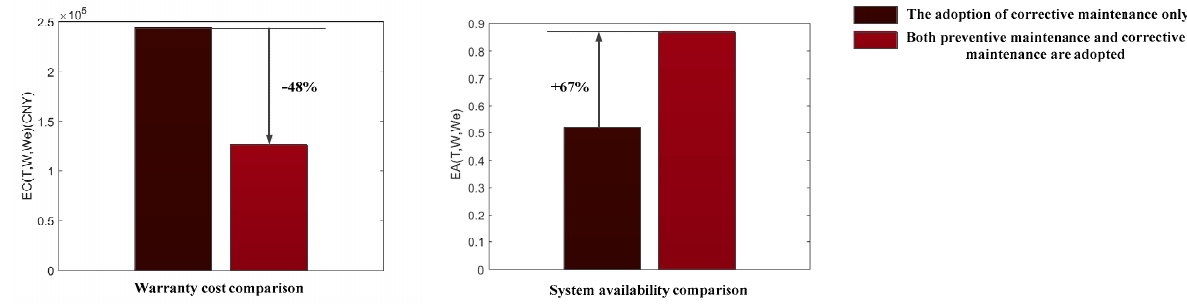
Figure 12. Comparison between systems with and without preventive maintenance.